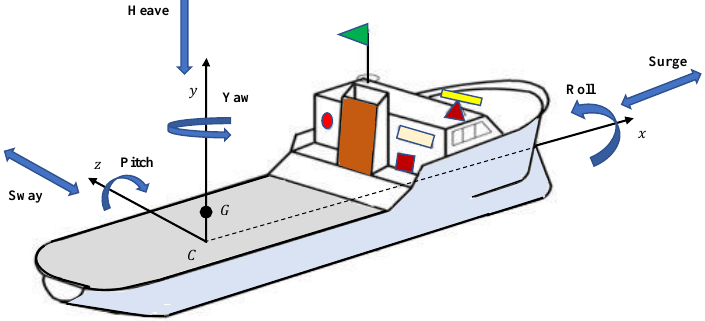
Figure 1. Schematic diagram of ship showing six directions of